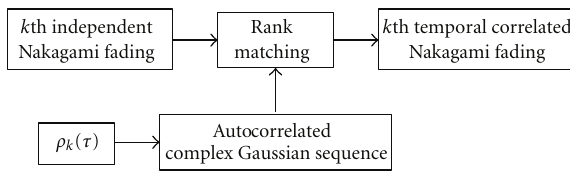
Figure 4: Introducing temporal